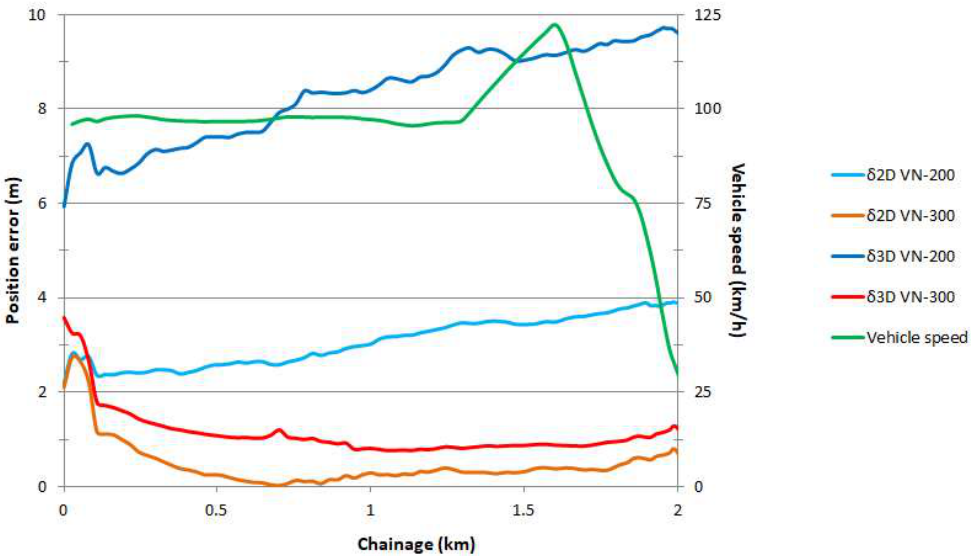
Figure 10. Variability in two-dimensional (2D) and three-dimensional (3D) position errors recorded by the VN-200 and VN-300 devices as a function of the route length when travelling at increased speeds (100–120 km/h) along section no. 7.